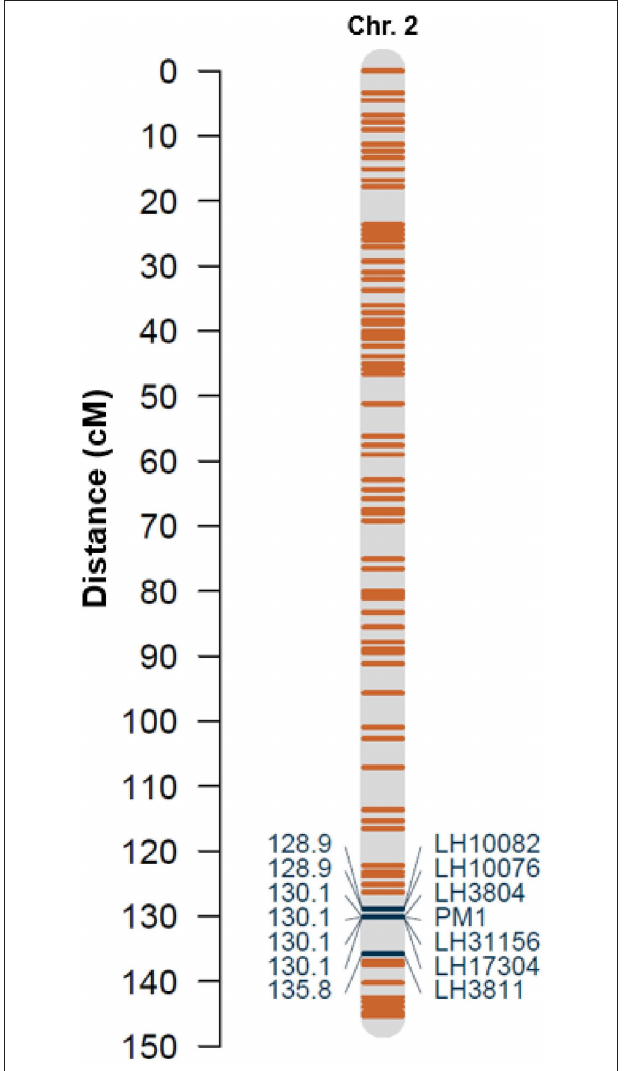
FIGURE 3 | Linkage map describing locations of selected markers on chromosome 2 (based on “CBDRx” chromosome naming). Resistance gene PM1 co-localizes with SNP markers LH3804, LH31156, and LH17304 on chromosome 2.